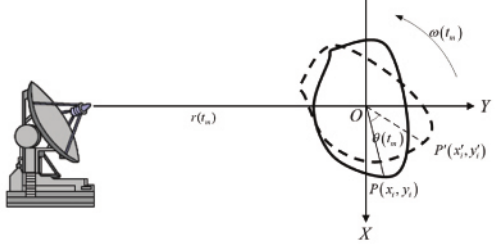
Figure 1. Geometry of the ISAR imaging